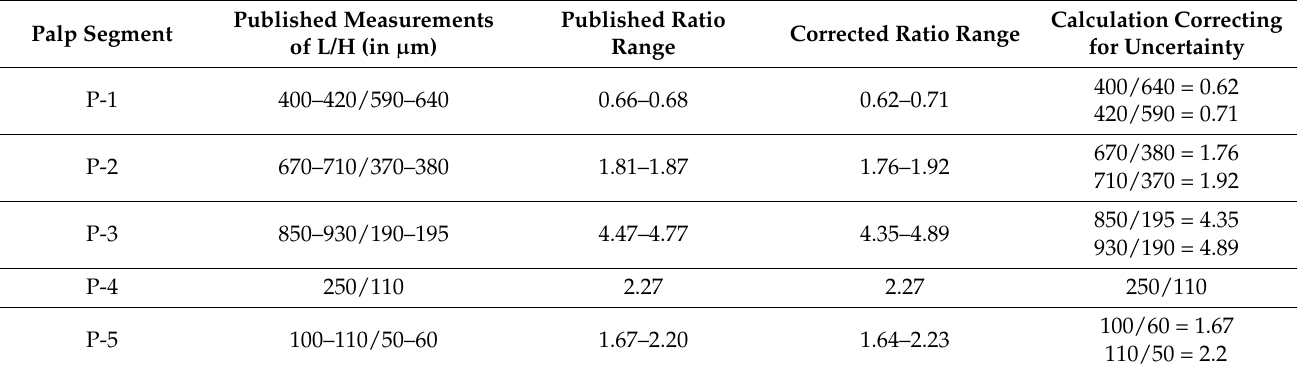
Table 4. Length ratio range for the five palp segments of Hydrachna geographica Müller, 1776 [7] (p. 43), and their values corrected for uncertainty following the steps outlined